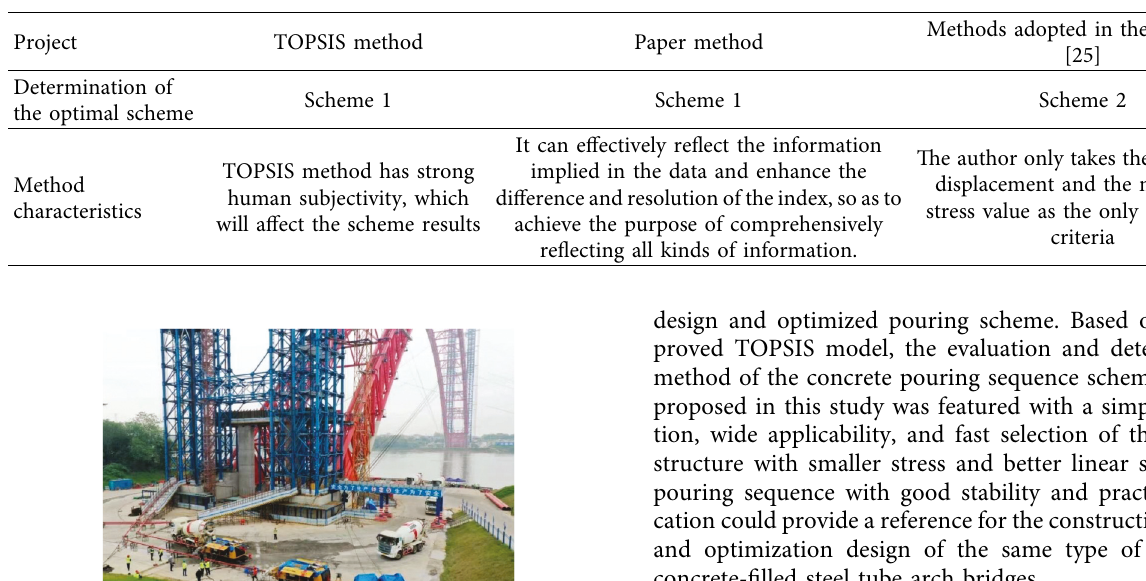
Table 3: Optimal perfusion schemes obtained by different methods.